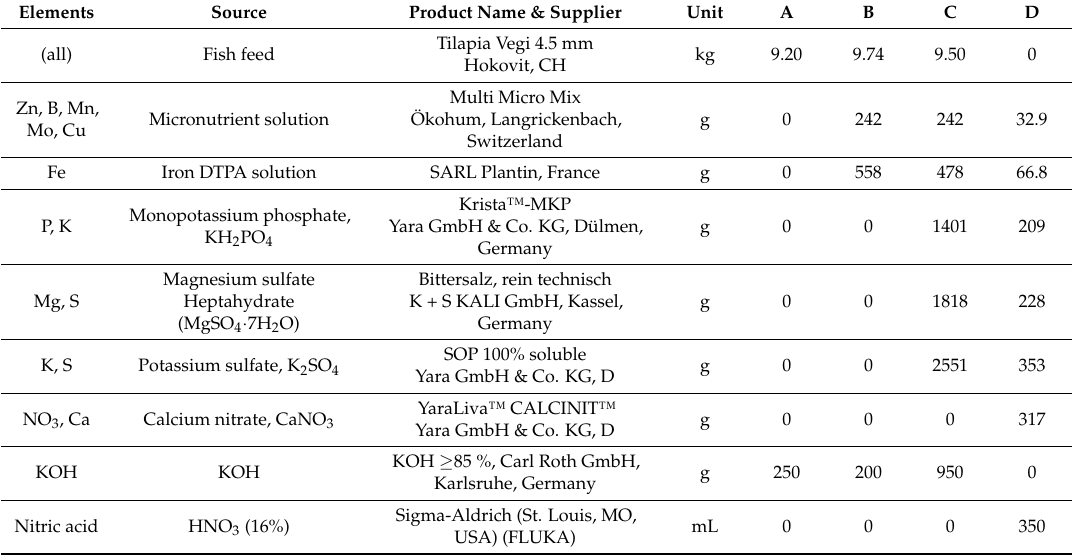
Table 4. Total input for the four experimental systems (A, B, and C = Aquaponic systems; D = Hydroponic